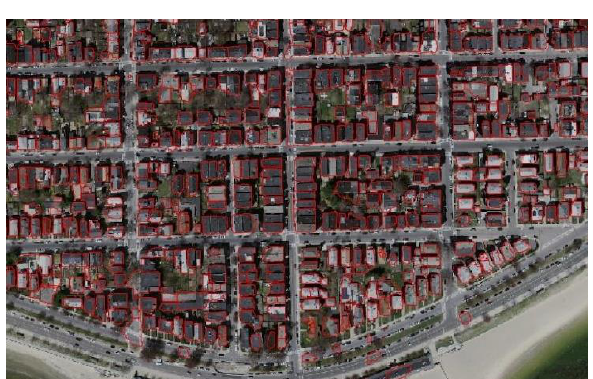
Figure 7 . 2 Model fail to detect buildings here due to poor building textures 8. VISUALIZATION OF RESULTS